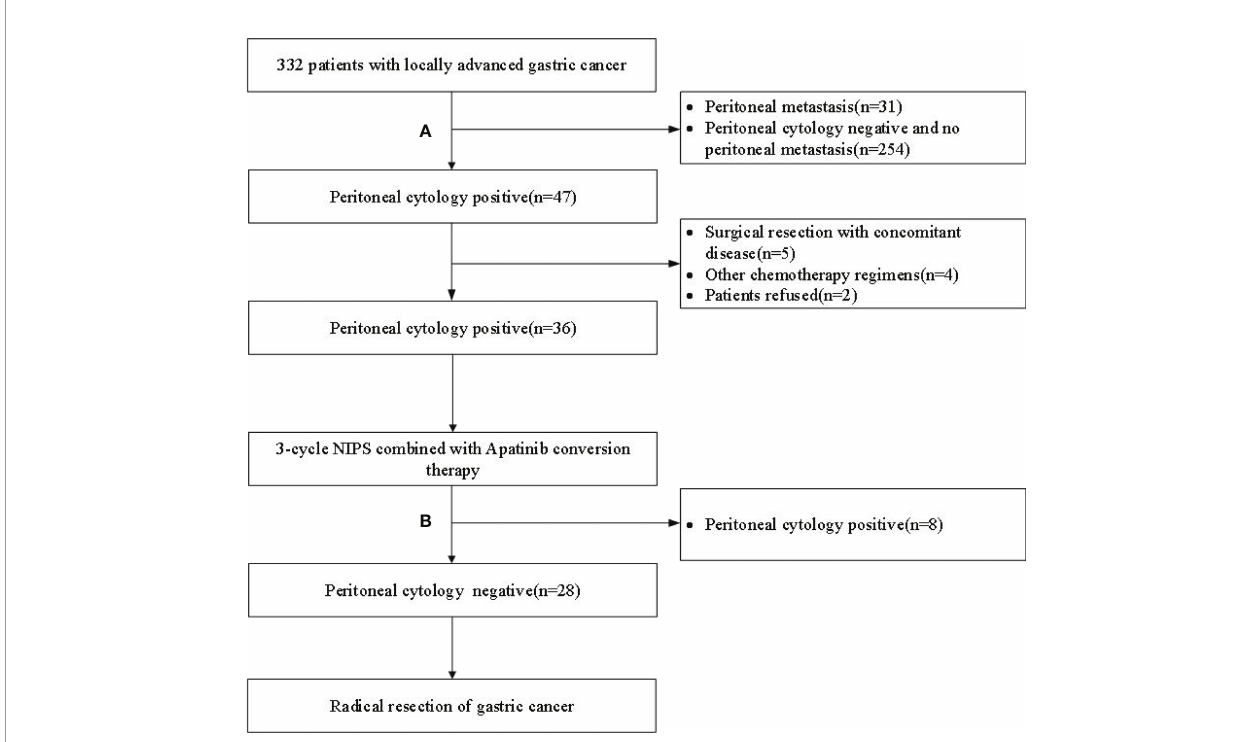
FIGURE 1 | Flow chart of patient enrollment and exclusion. (A) Laparoscopic exploration + peritoneal cytology; (B) Re-laparoscopic exploration + peritoneal cytology; NIPS, Neoadjuvant intraperitoneal and